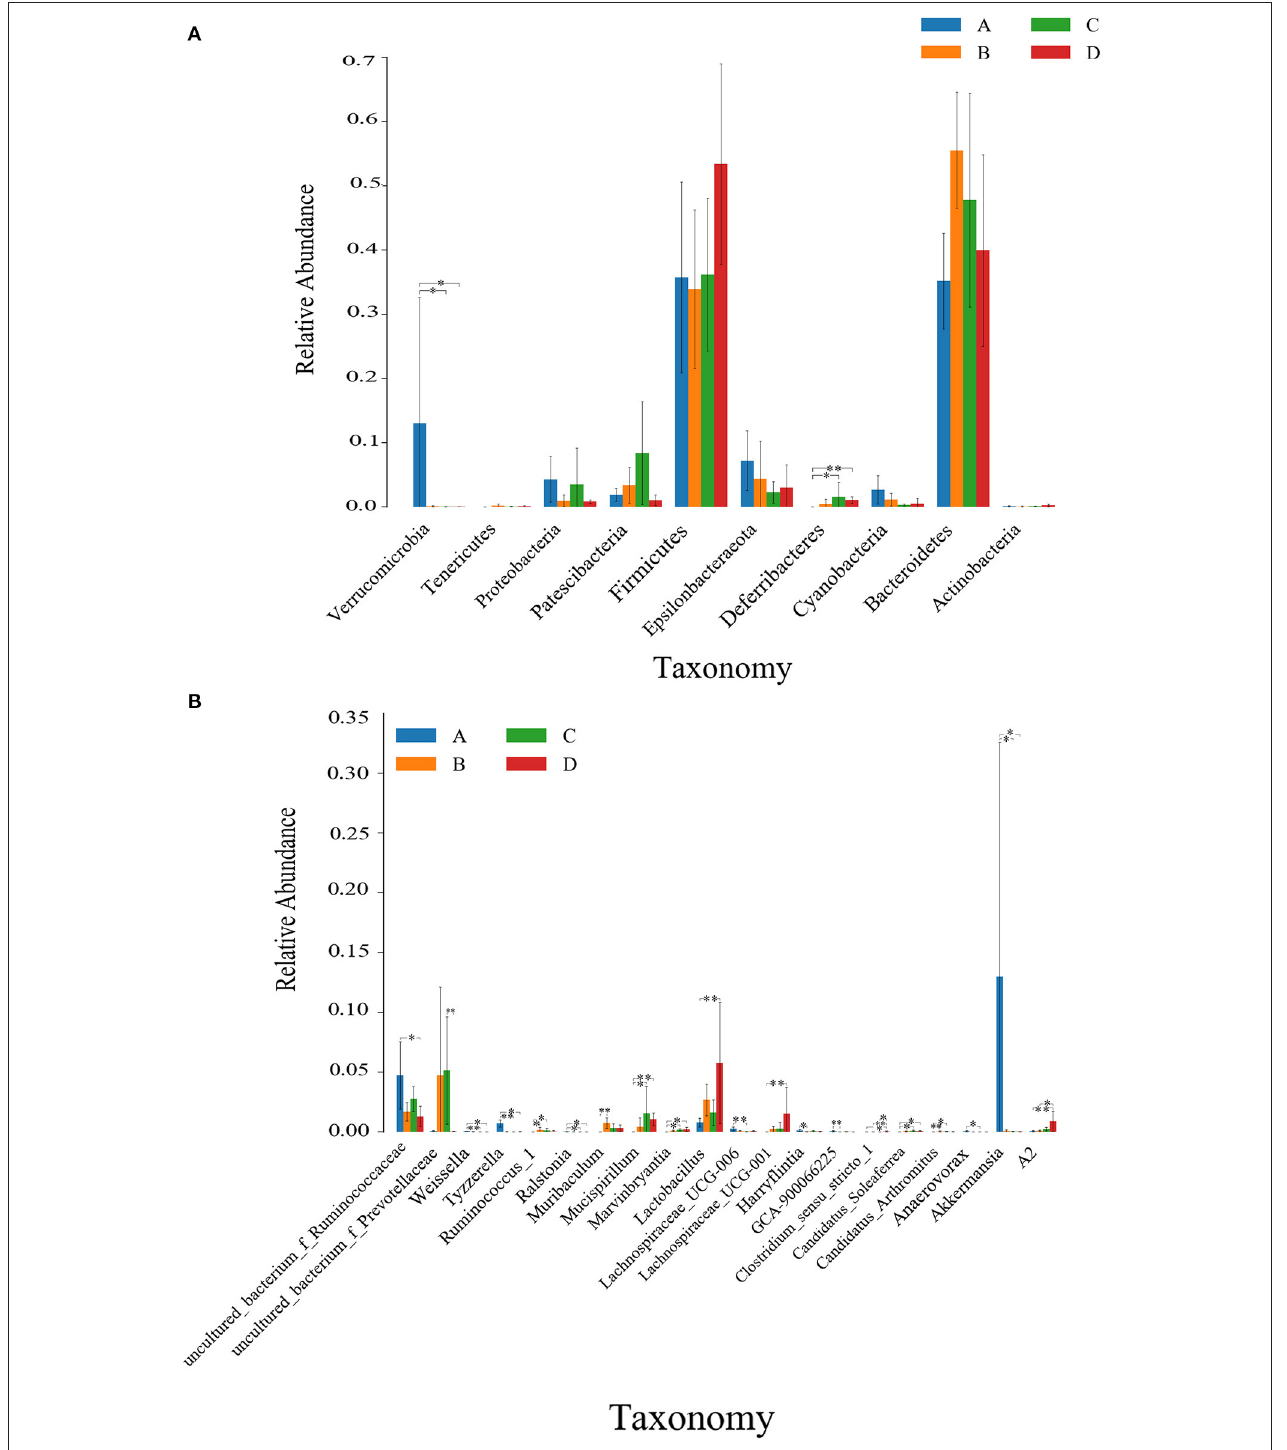
FIGURE 4 | Histogram of Kruskal Wallis rank sum test at phylum (A) and genus levels (B) between groups. * on the column indicating significant difference ( P < 0.05); and * * indicating extremely significant difference ( P < 0.01). A: NT-free group; B: basal diet group; C: NT intervention group; D: model control group.